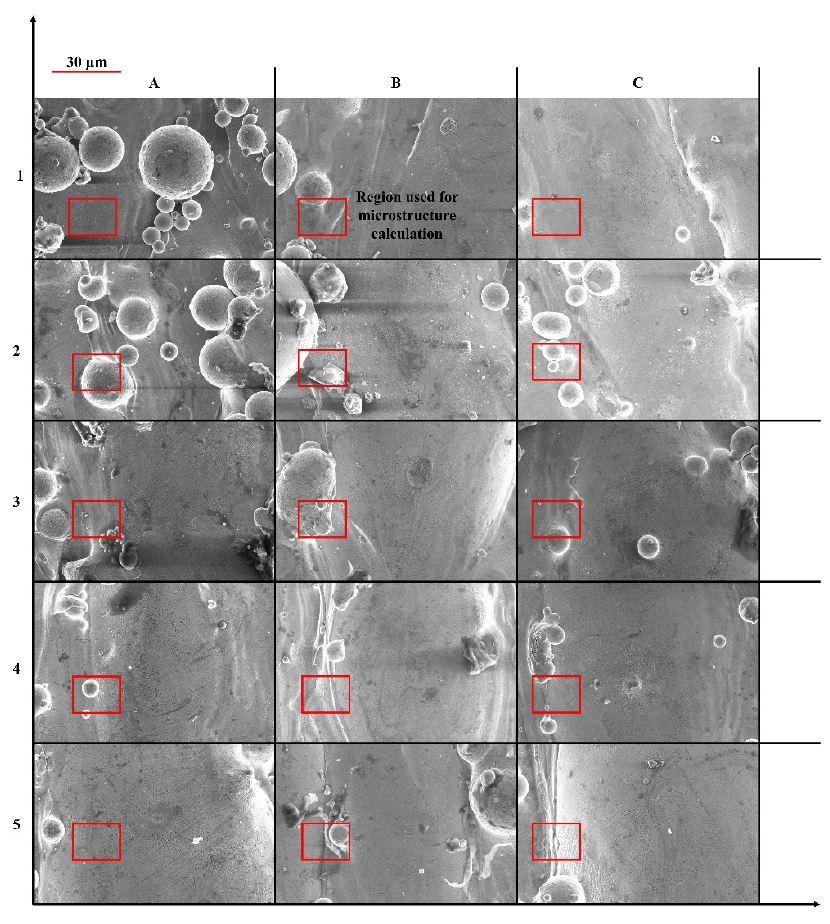
Figure 8. Morphologies of 15 printed samples with lack of fusion defects: A1–A5 (1st column), B1–B5 (2nd column), and C1–C5 (3rd